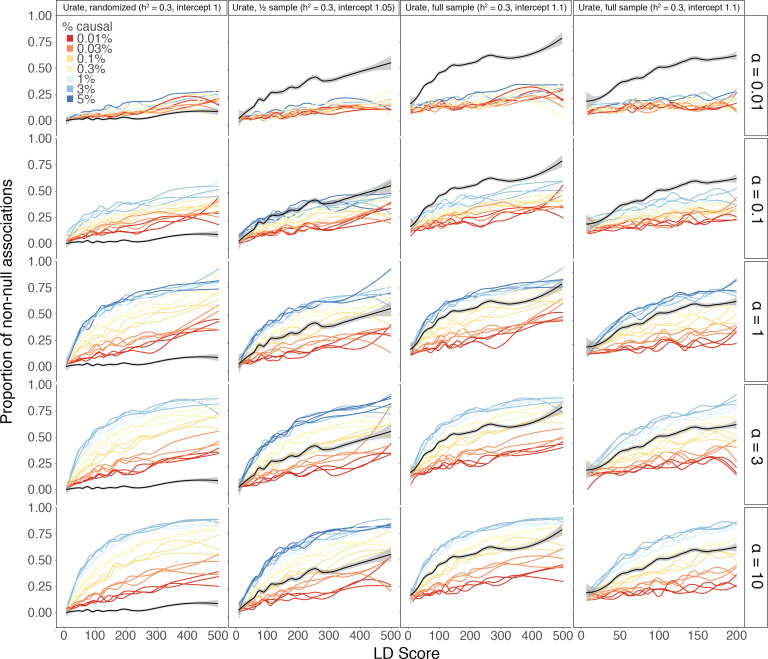
Estimates of causal sites are conservative with respect to SNP concentration within the genome.Rather than drawing SNPs uniformly at random from those with MAF >1% (Materials and methods), instead each megabase window was assigned a distinct probability ρ of SNPs being causal within that megabase window. For a given causal fraction c, ρ was drawn at random from B⁢e⁢t⁢a⁢(α,α/c). Thus, the mean causal fraction across all megabase windows in the genome is still c, and this fraction is concentrated more in single windows under decreasing values of α. The standard results shown in main text correspond to α=∞. As we decrease α, the estimates consistently increases, regardless of the same size or LD Score axis threshold. However, the results consistently stay above the randomized version of the trait, suggesting that the estimates remain non-zero even for very concentrated SNP-based heritability.